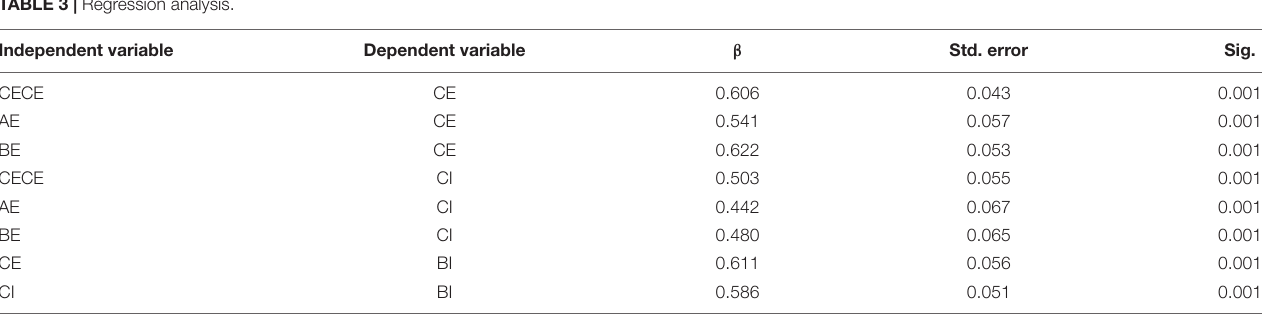
TABLE 3 | Regression